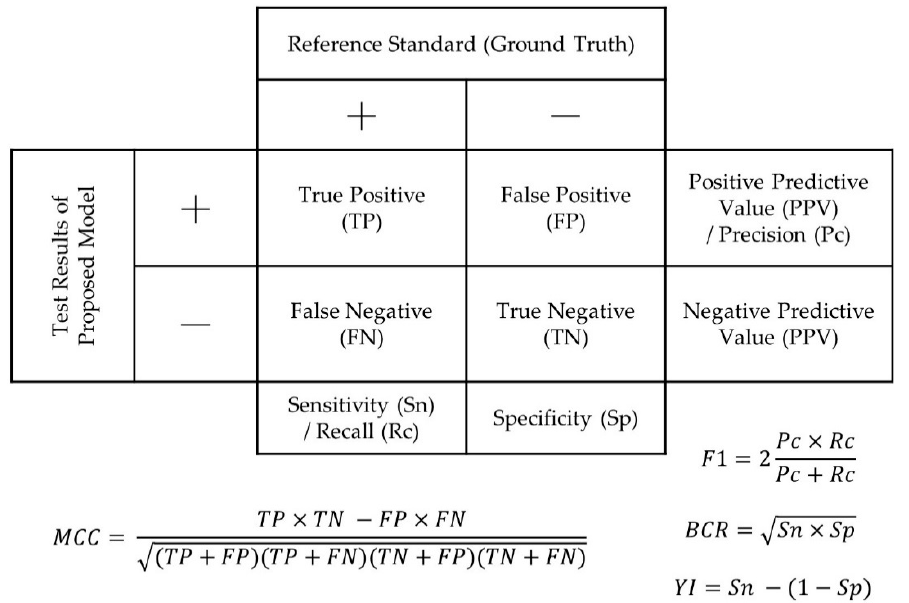
Figure 2. Confusion matrix demonstrating typical outcome measures used for model evaluation. (BCR/G-mean: balanced classification rate; MCC: Matthews correlation coefficient; YI: Youden’s in- dex).